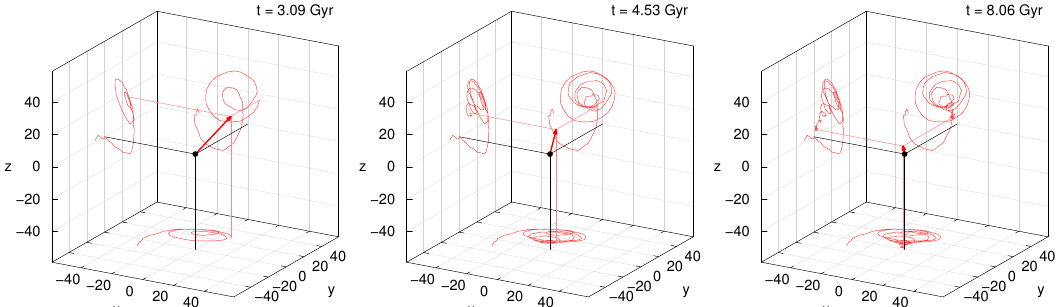
Figure 6. Illustration of the direction of the total stellar angular momentum in three-dimensional space as a red vector at three different time steps, of the simulation as given in the label. The red curves drawn on the coordinate planes trace the projected paths of the vector’s endpoint until its current